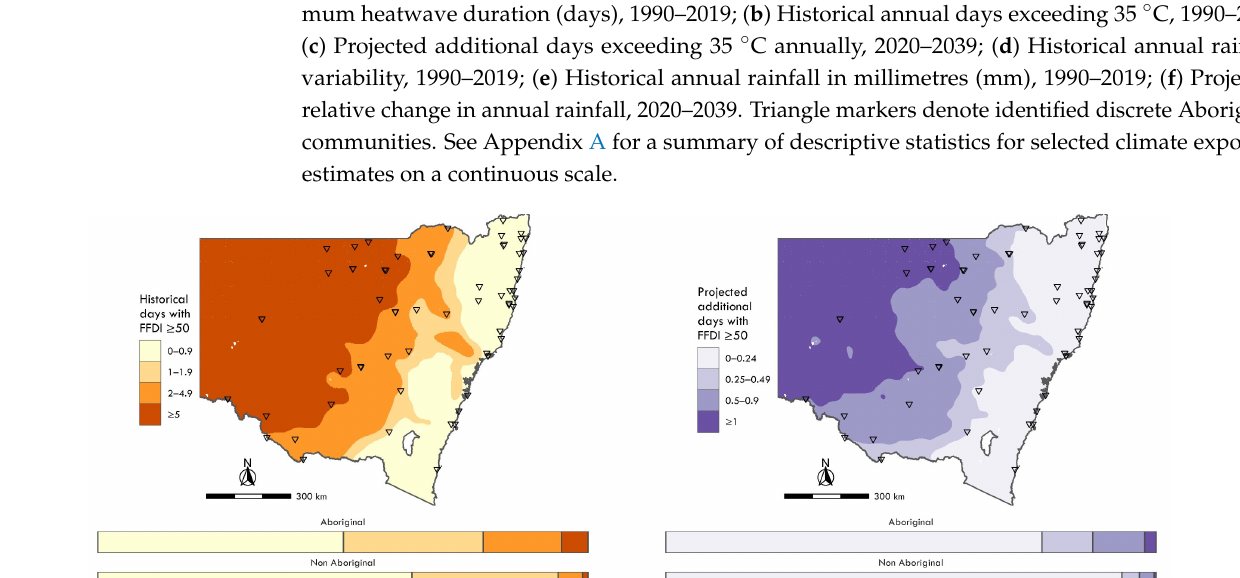
Figure 2. Maps of climate exposures with bar charts indicating relative exposure by category across Aboriginal and non-Aboriginal populations. Exposures include: ( a ) Historical annual average max-